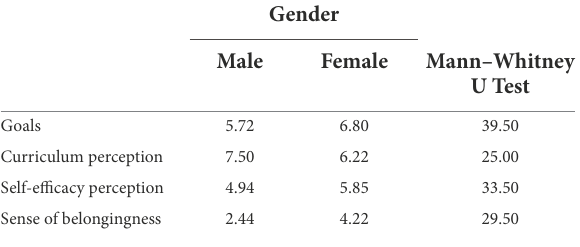
TABLE 1 Mann–Whitney U Test on dropped out students (male vs. female).